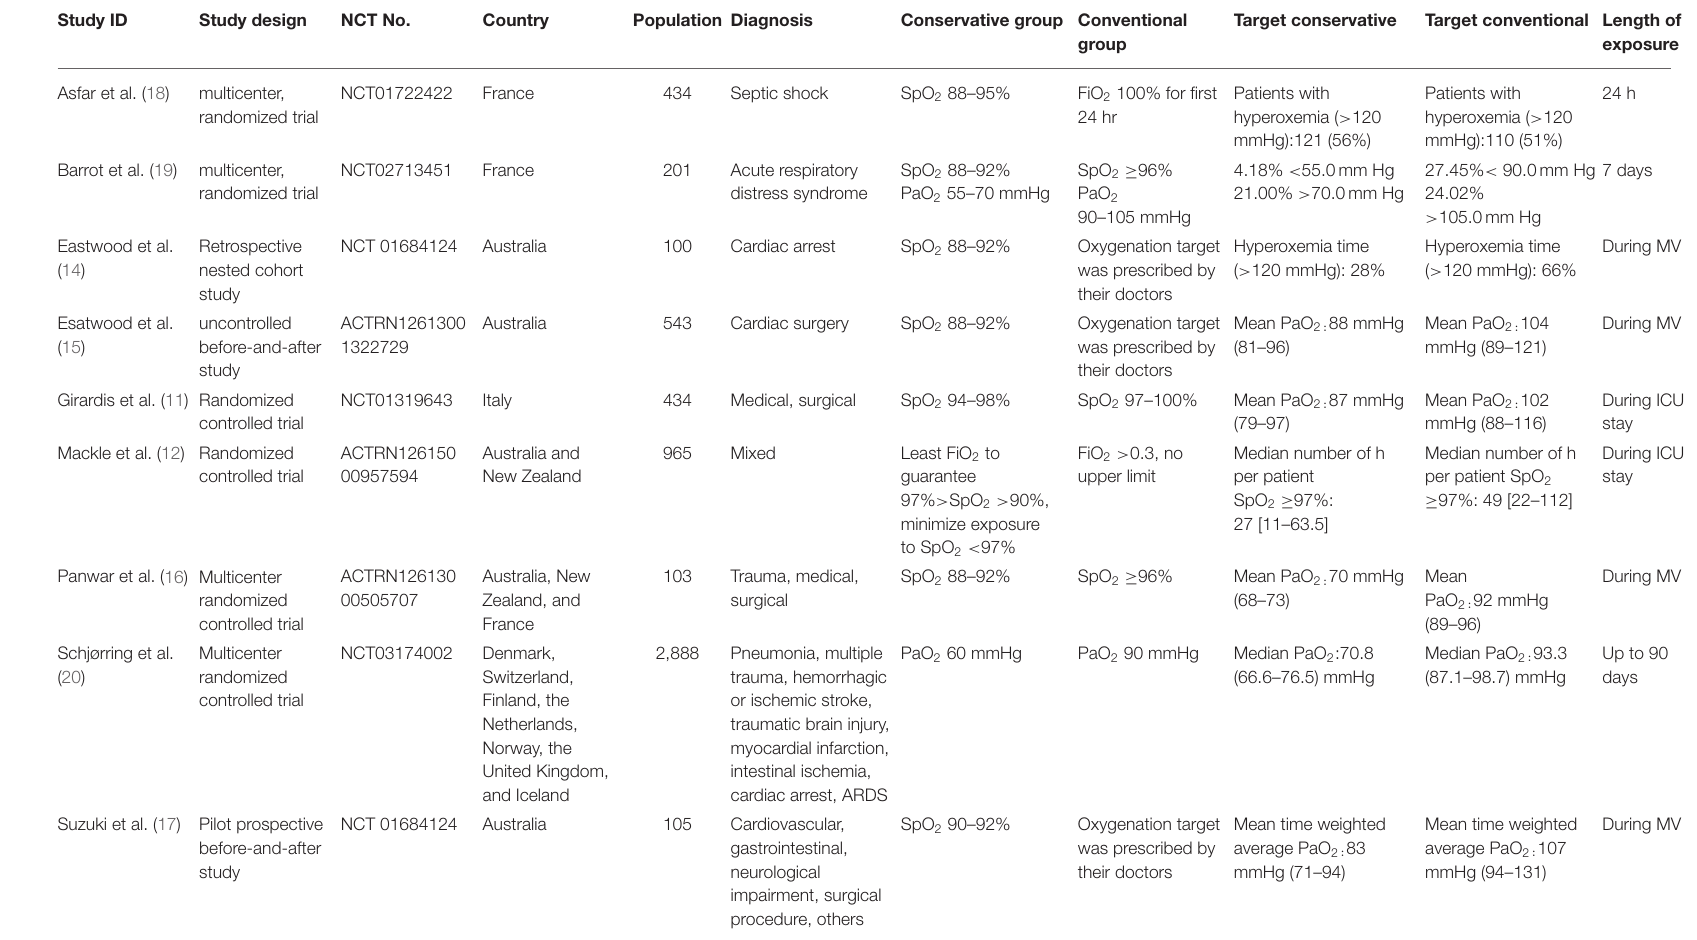
TABLE 1 | Characteristics of included